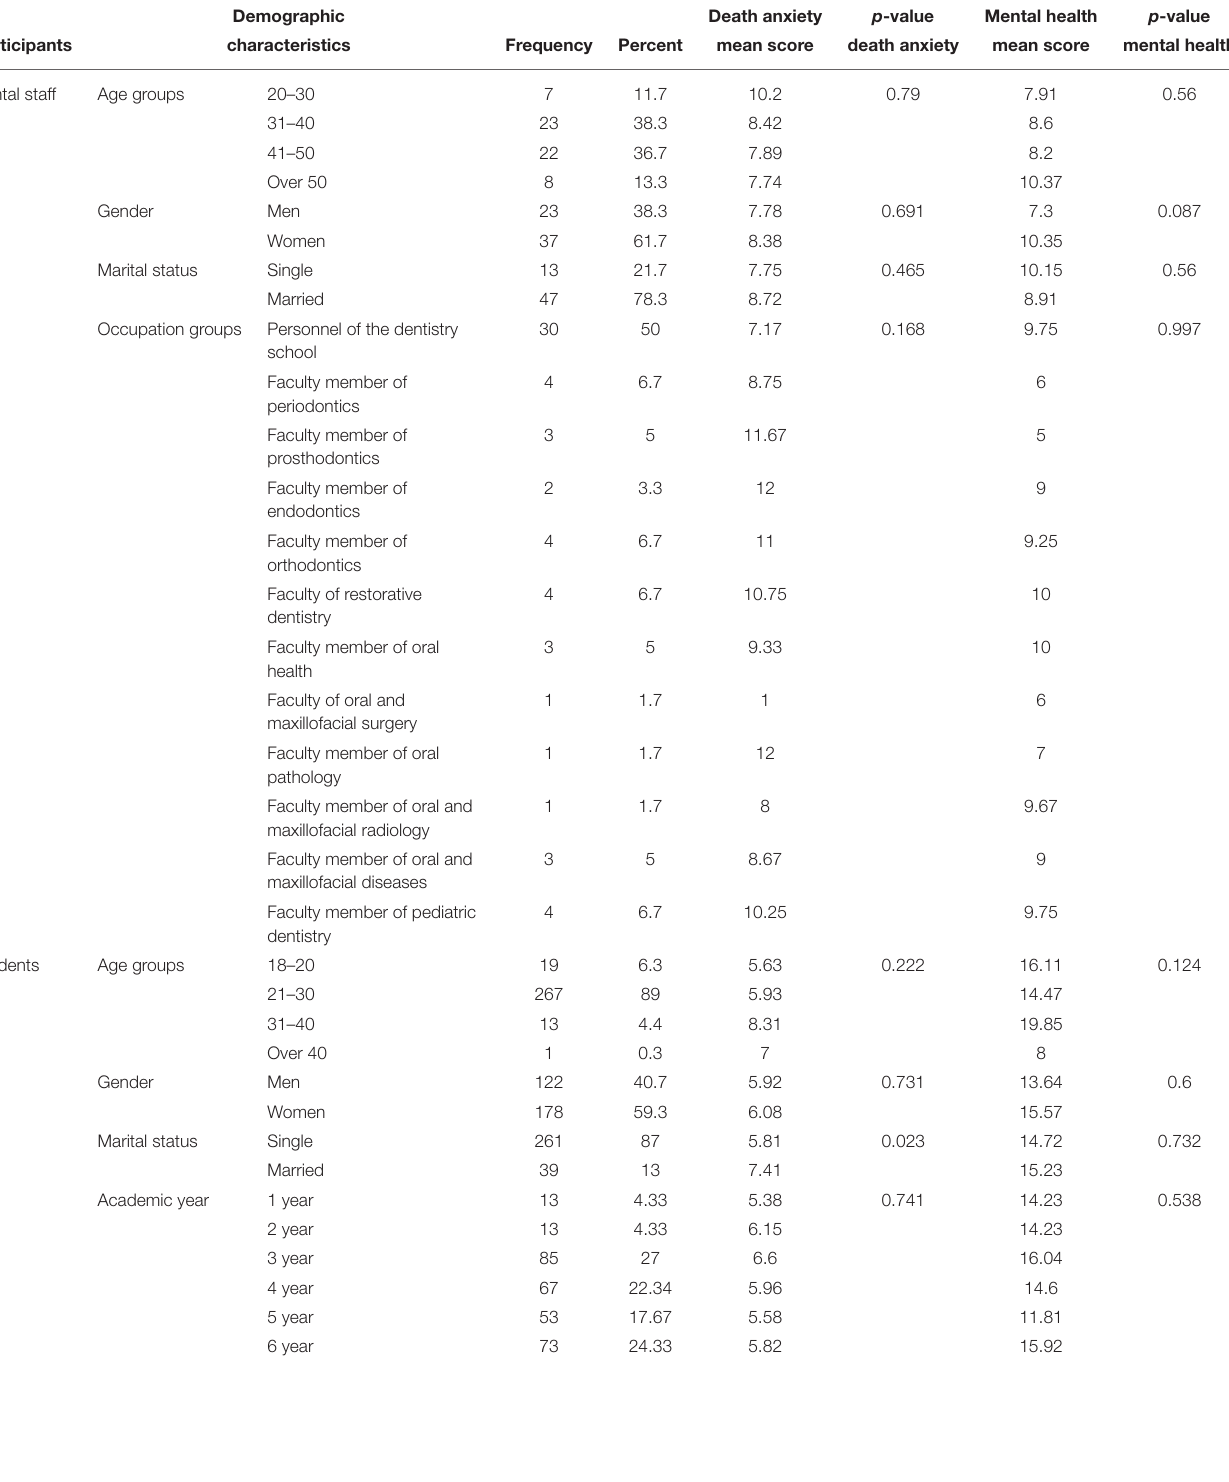
TABLE 1 | Mean scores of death anxiety and mental health status in dental students and dental staff according to their demographic characteristics. Demographic Death anxiety p -value Mental health p